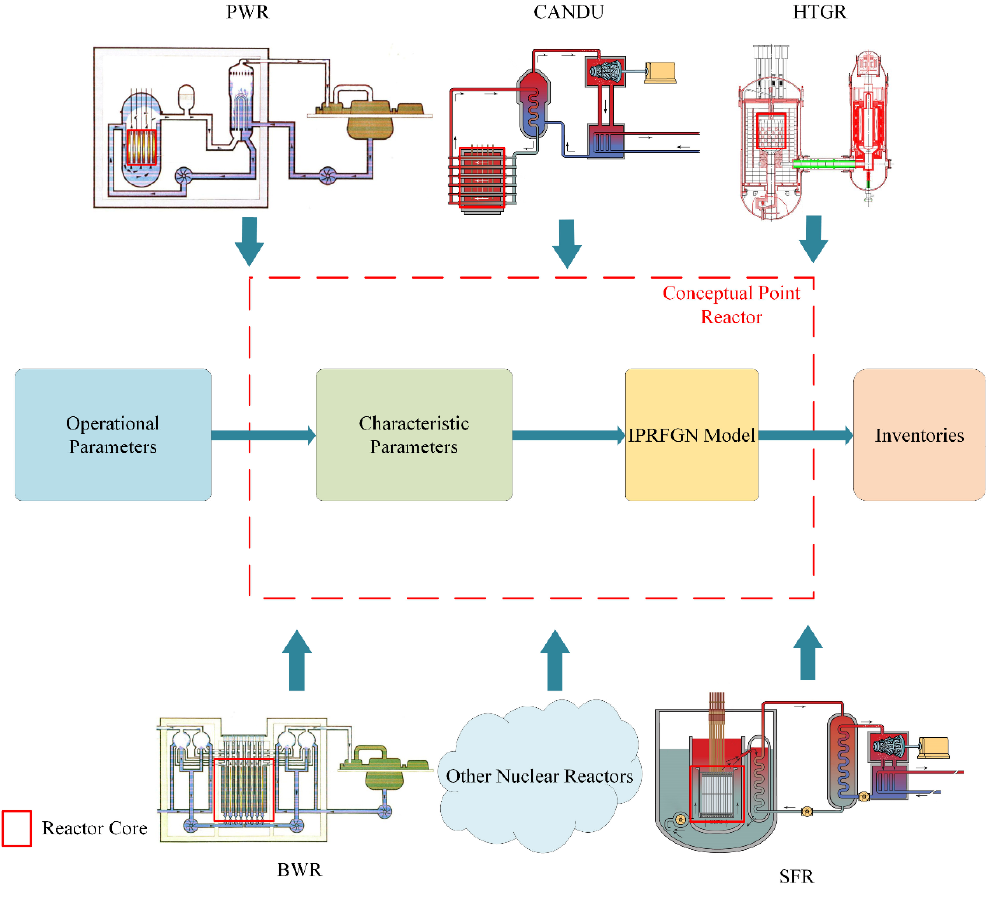
Figure 1. Schematic of the IPRFGN model [51,52] .